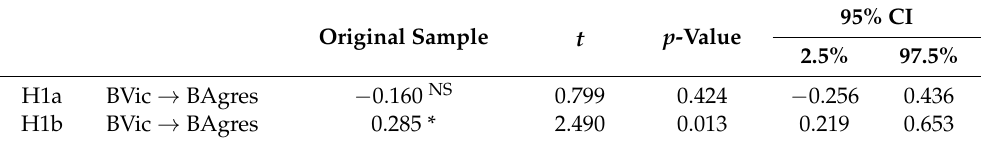
Table 7. Hypothesis